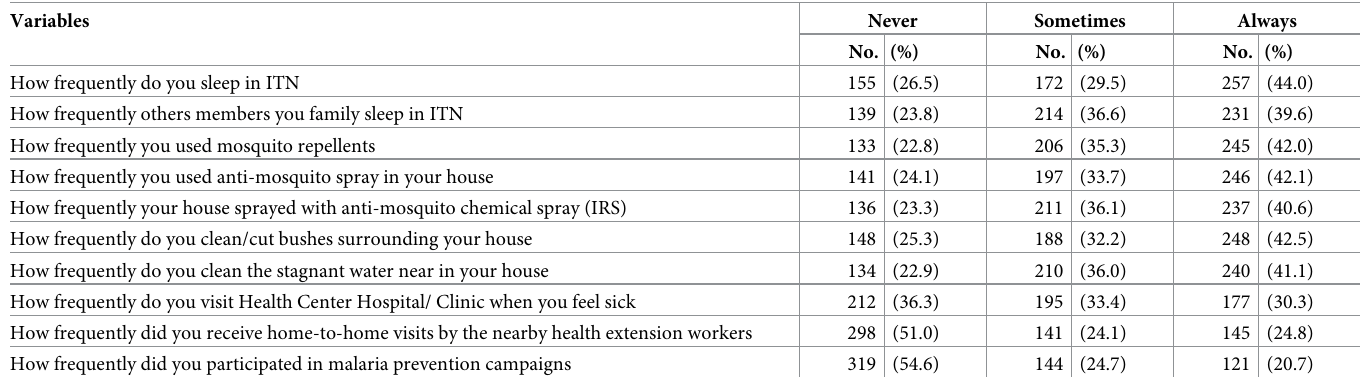
Table 4. Practice of malaria prevention among households at in Hawassa City, South Ethiopia, 2020.